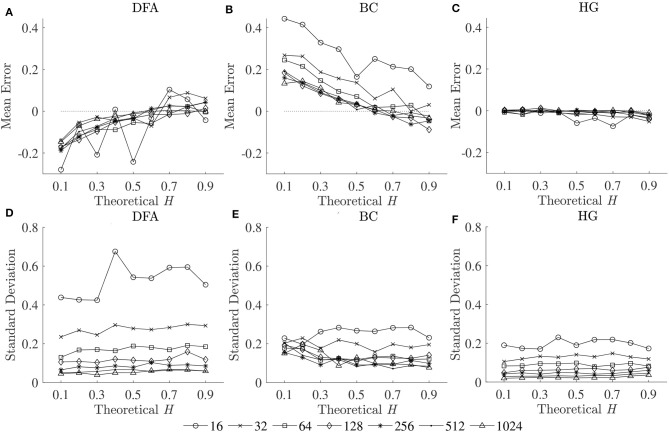
Mean errors (upper panels) and standard deviations (lower panels) of estimated Ĥ for three fractal methods: (A,D) DFA, (B,E) BC, and (C,F) HG.